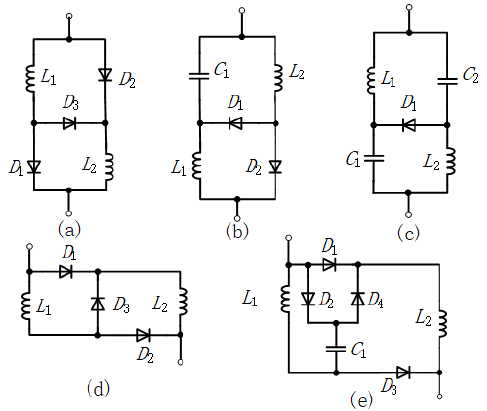
Figure 21. S witched inductors. ( a ) [37]. ( b ) [42]. ( c ) [43]. ( d,e ) [44]. Figure 21. Switched inductors. ( a ) [37]. ( b ) [42]. ( c ) [43]. ( d,e ) [44]. Table 5. Circuits and voltage gain for